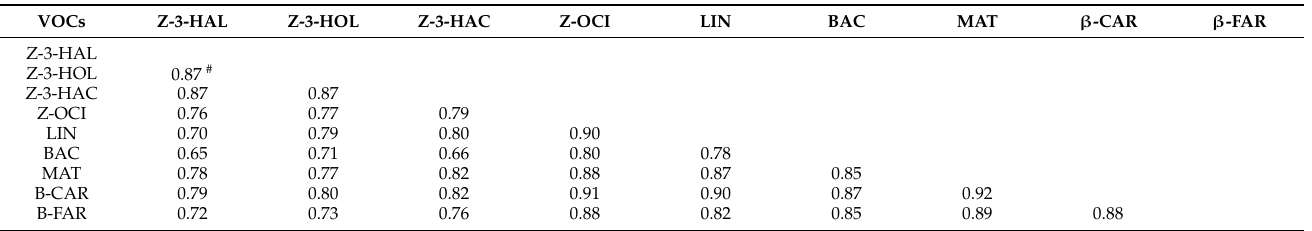
Table 1. Correlation coefficients between particular pairs of GLVs emitted from R. confertus after ZJA application.